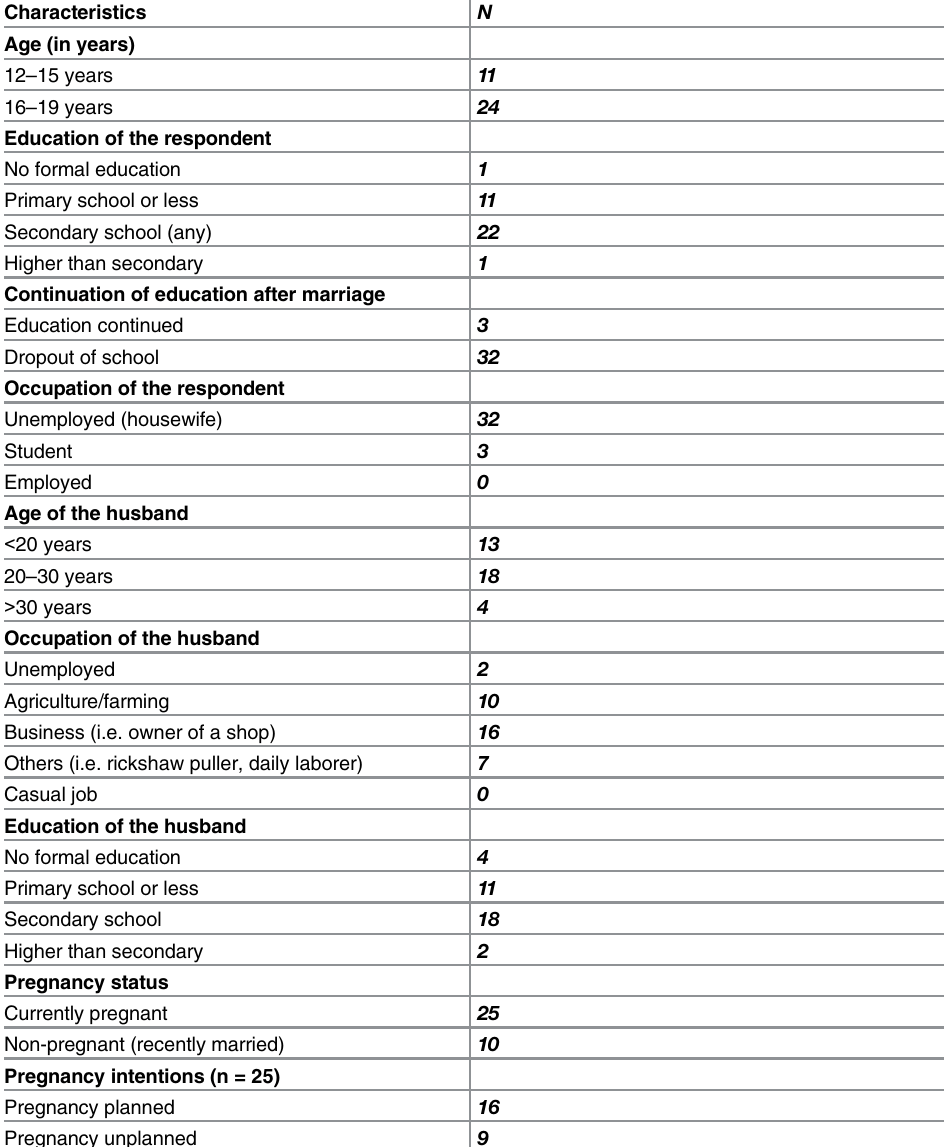
Table 2. Background characteristics of study participants (n = 35).